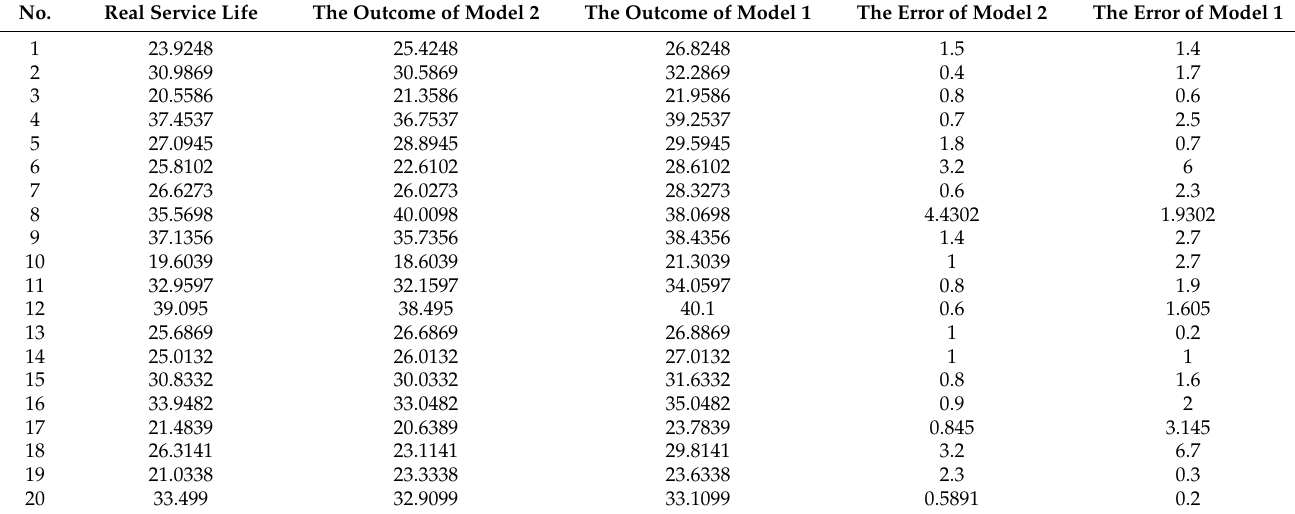
Table 4. Analysis of the results of pipeline service